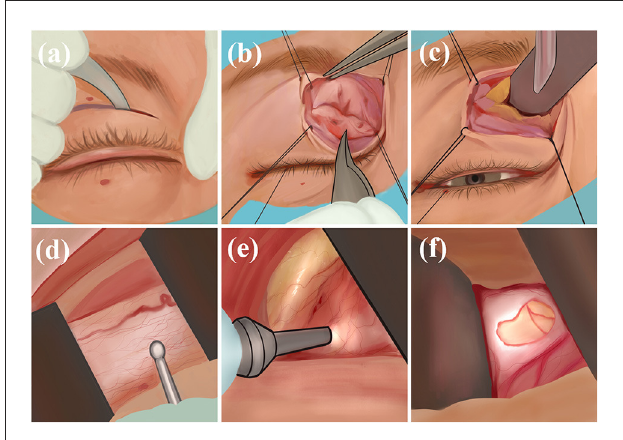
FIGURE3 Transepithelial medial eyelid approach: (a) Incise the skin; (b) incise orbicularis oculi muscle; (c) bluntly separate the medial fat in the upper eyelid; (d) expose the optic nerve sheath; (e, f) incise and drain.